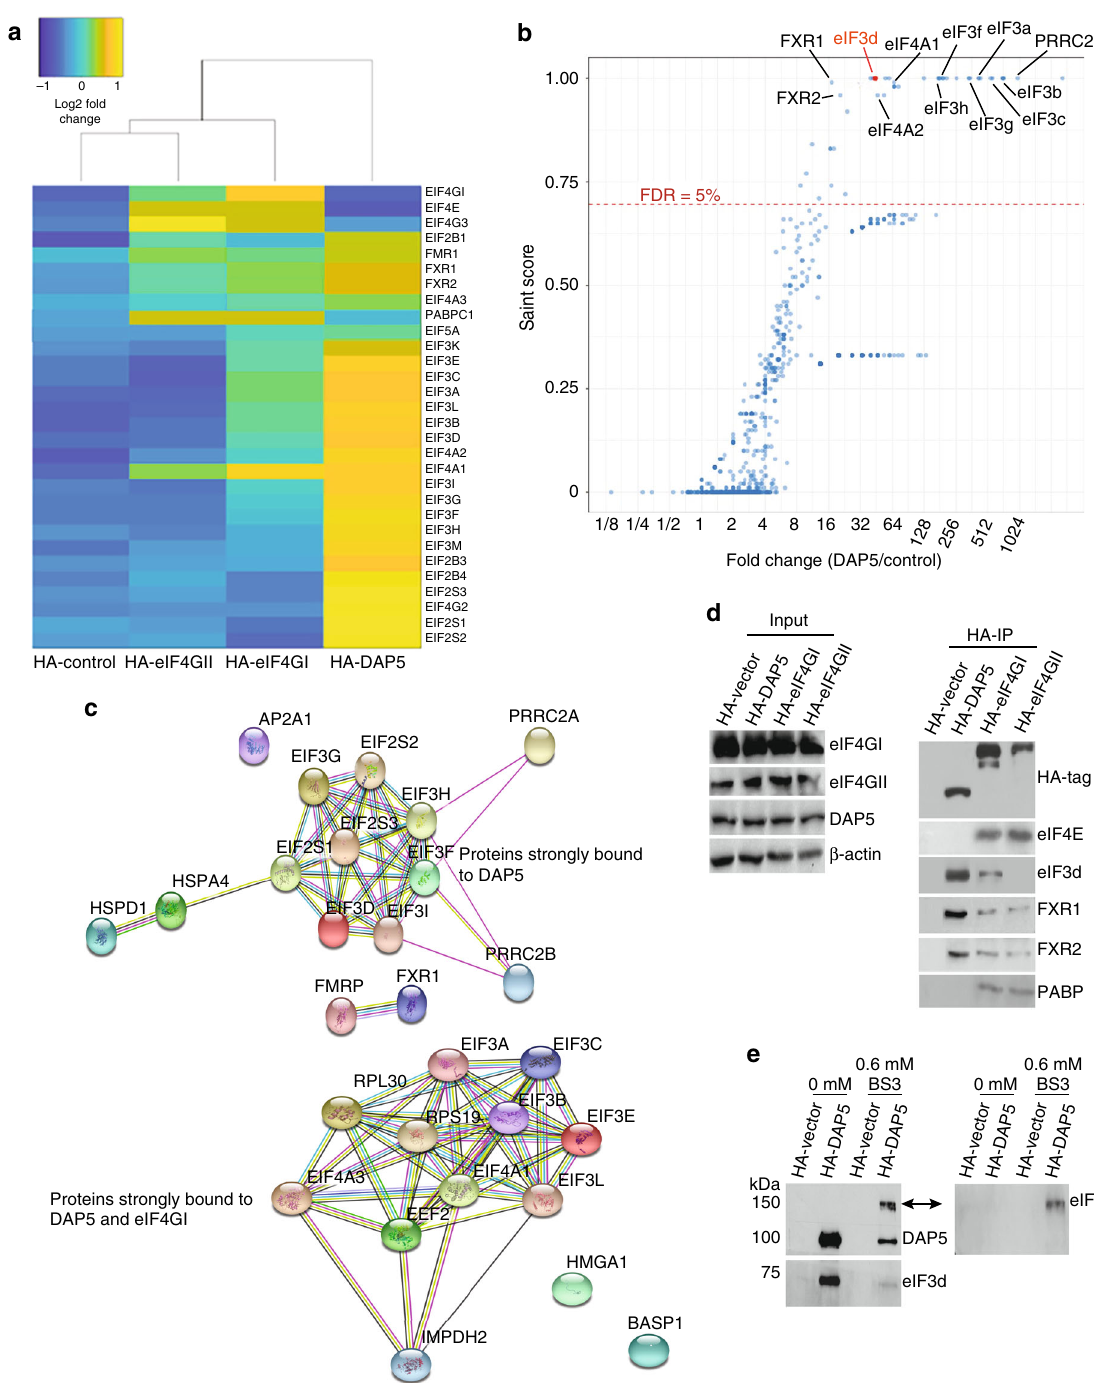
Fig. 3 Proteomic analysis of the eIF4G family. a Heat map of top-ranked interacting proteins with DAP5, and/or eIF4GI, eIF4GII, and HA-control (HA protein alone). Cluster analysis carried out based on the intensity and coverage of proteins by mass spectrometry (LC-MS). Yellow and blue, respectively, represent strongest and weakest binding proteins to eIF4GI, eIF4GII, and/or DAP5 ( n = 3). b eIF3d identi fi ed as one of the strongest DAP5-binding partners. SAINT score was plotted against the ratio of spectral counts in the DAP5 immunoprecipitation (IP) over control (HA-IP). Five percent FDR cutoff shown. Protein identi fi cation results are labeled for the MS analysis of af fi nity puri fi cation ( n = 3) for DAP5 using the SAINT algorithm. c Data analysis using SAINT algorithm of the top-ranked protein interactions (SAINT score > 0.7): (top) proteins interacting exclusively with DAP5; and (bottom) proteins interacting in common with DAP5 and eIF4GI. See Supplementary Data Fig. 3 for STRING analysis of eIF4GI, eIF4GII-interacting proteins, and Supplementary Data 2 for source data. d IP and immunoblot analysis validation of HA-DAP5-, HA-eIF4GI-, and HA-eIF4GII-interacting proteins. e In vivo crosslinking with bis(sulfosuccinimidyl) BS3 before cell lysis and IP of HA-DAP5. Immunoblot analysis con fi rms crosslinking of DAP5 and eIF3d by appearance of band in SDS-denaturing gel at higher molecular weight > 150 kDa (arrows), identi fi ed by anti-DAP5 and anti-eIF3d antibodies only from cells treated with BS3. Membrane was fi rst immunoblotted with anti-DAP5, then stripped and re-probed for